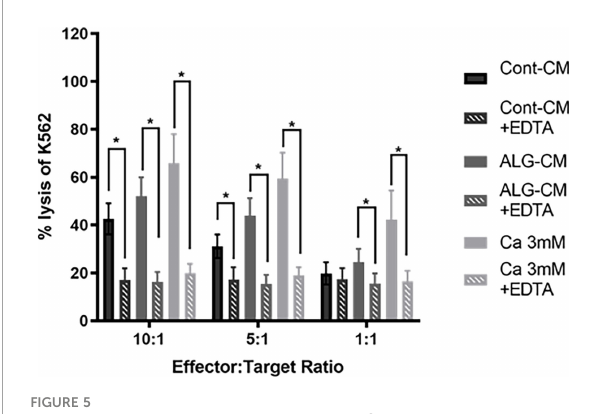
FIGURE 5 Impact of the depletion of extracellular Ca 2+ on NK cell cytotoxic activity. The cytotoxic activity of NK cells was assessed in the presence of EDTA by a fl ow cytometry-based assay using puri fi ed NK cells from healthy donors as effector cells and K562 cells as target cells at the indicated effector: target (NK: K562) ratios. EDTA was added to conditioned medium (ALG-CM) (grey hatched bars) or CaCl 2 solution at 3mM (light grey hatched bars). NK cells were incubated with CFSE-labeled K562 for 18h. Results are the mean of the percentage of 7-AAD positive K562 ± SEM of 6 independent experiments. Statistics compared to each media without the addition of EDTA ( fi lled bars) using Wilcoxon paired test * p <0.05.